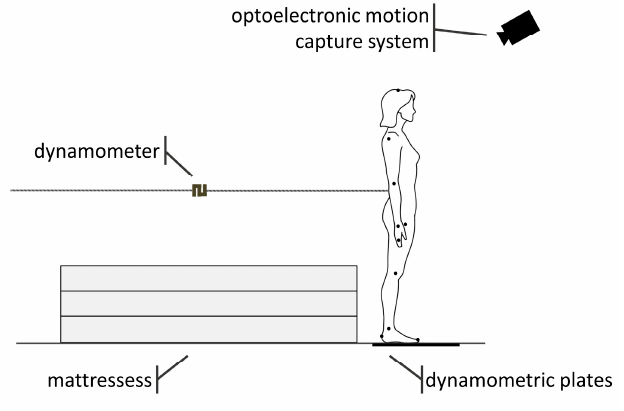
Figure 1. Diagram of the experimental setup (right-hand view in the XY-plane). To capture the body position during the exercises, passive markers were placed on the body of the subject. Shown in Figure 2, the placement of nineteen passive markers on the surface of a person’s body results from the assumptions of the Dempster model about the division of the human body into segments. Moreover, two markers attached to the rope make it possible to define the direction of the external